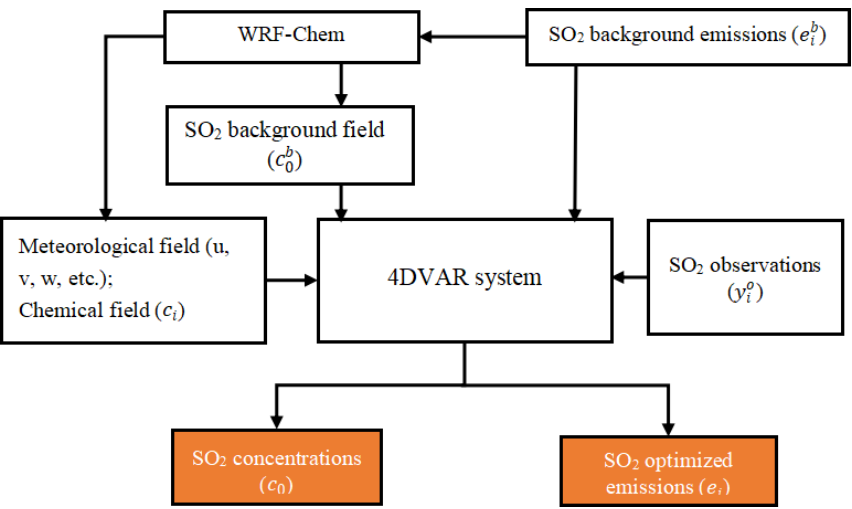
, c 0 , e b , e i , and y o are the mathematical symbols from Eq. (1). i i 0